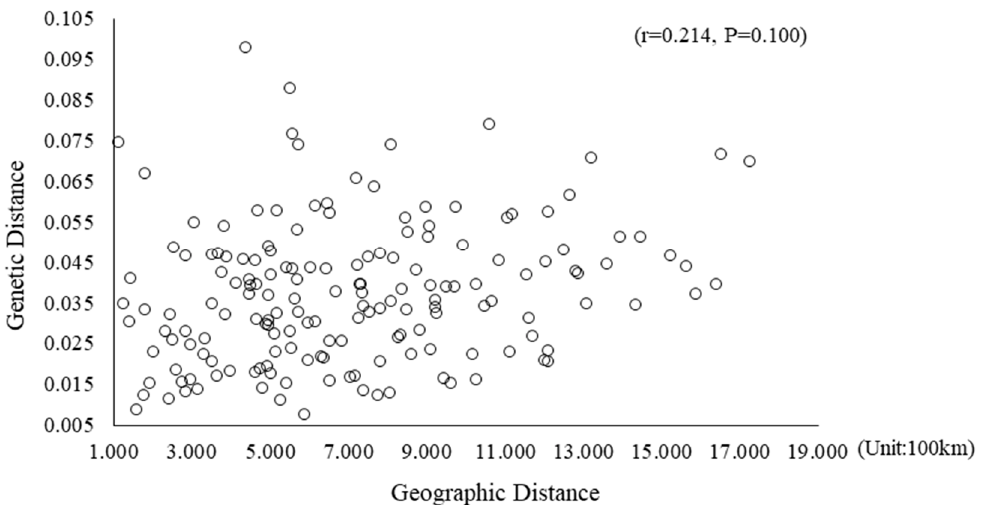
Figure 3. Relationship between genetic distance and geographic distance for all black locust provenances (The X -axis scale is 0.010, and the Y -axis is 2.000). Genetic distance was computed based on pairwise F ST /(1 − F ST ) estimates among provenances.